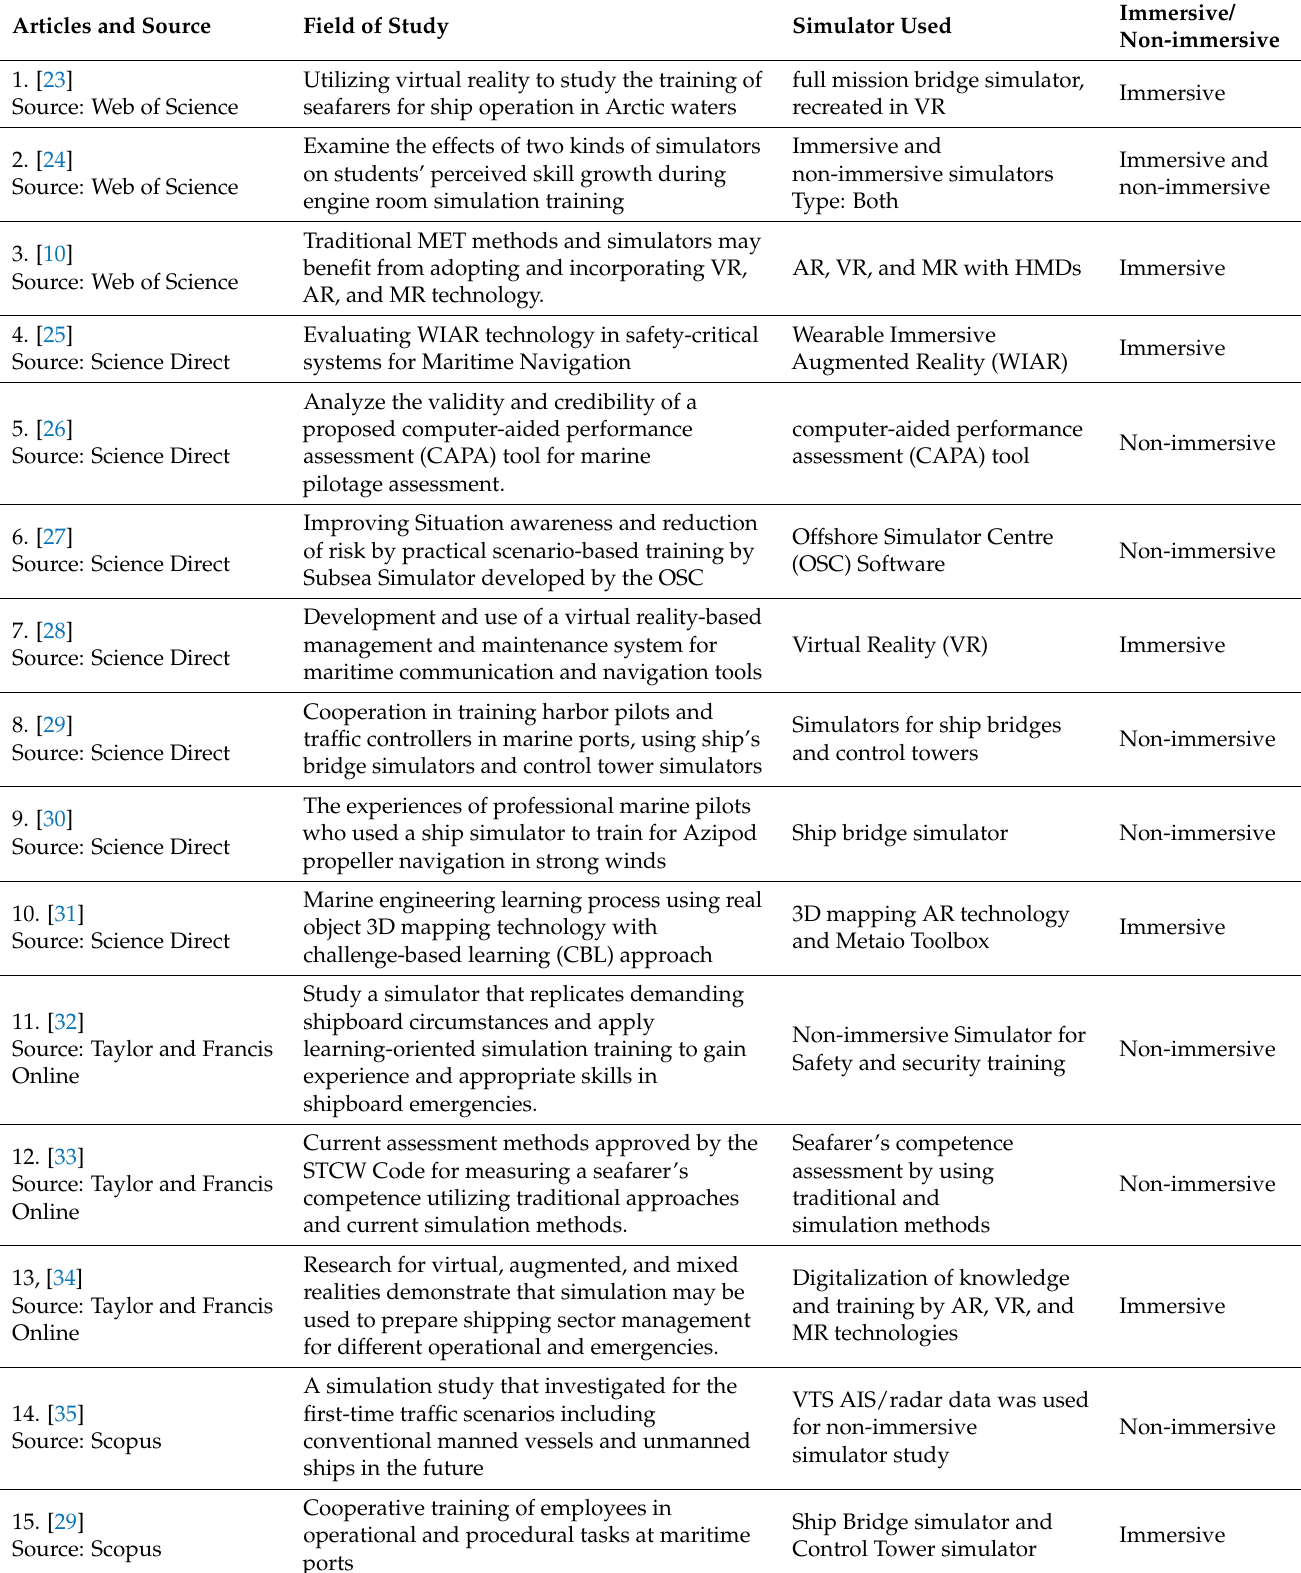
Table 3. List of Selected Articles, their Data Source, Field of studies, Simulator